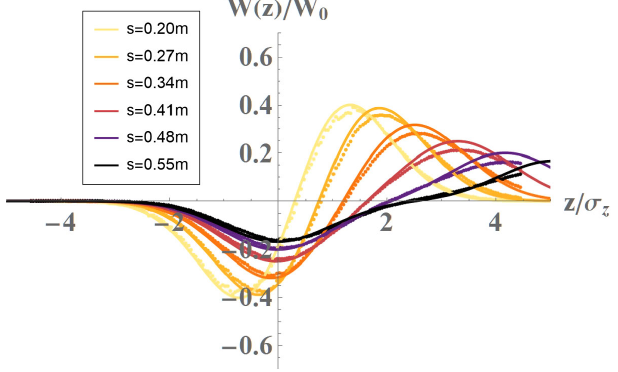
FIG. 13. Evolution of W 1 ð z Þ inside magnet B2 in beamline C by theory prediction [See Eq. (105)]. The evolution is similar to Fig. 10 since they both show entrance wakes. The darkest curve at s ¼ 0 . 68 m corresponds to the steady state wake in B2.